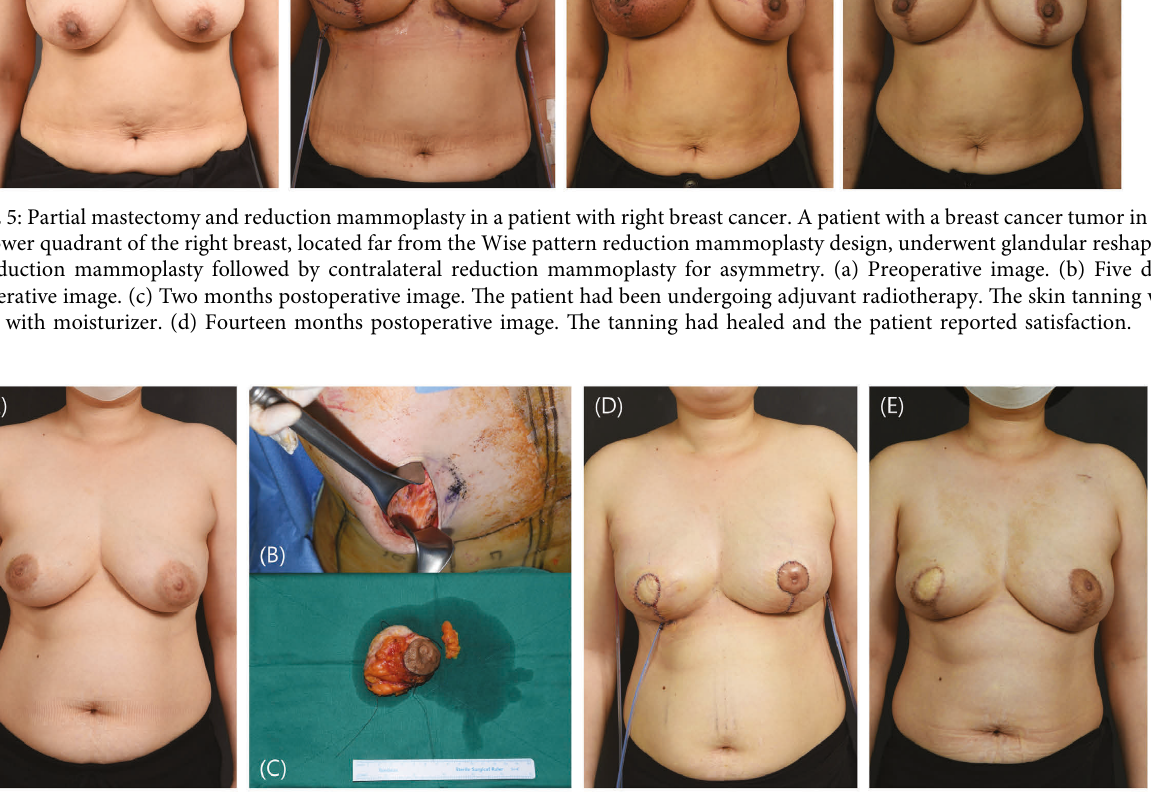
Figure 6: Partial mastectomy and reconstruction mammoplasty of patients with centralized right breast tumor. A patient with a tumor involving the nipple-areolar complex (NAC) of the right breast underwent tumor reduction mammoplasty with a superomedial pedicle. The deepithelized inferior tissue was transpositioned to the neo-NAC area for delayed NAC reconstruction. (a) Preoperative image. (b, c) The defect and the mass are shown intraoperatively. (d) Five days postoperative image. (e) One year postoperative image.